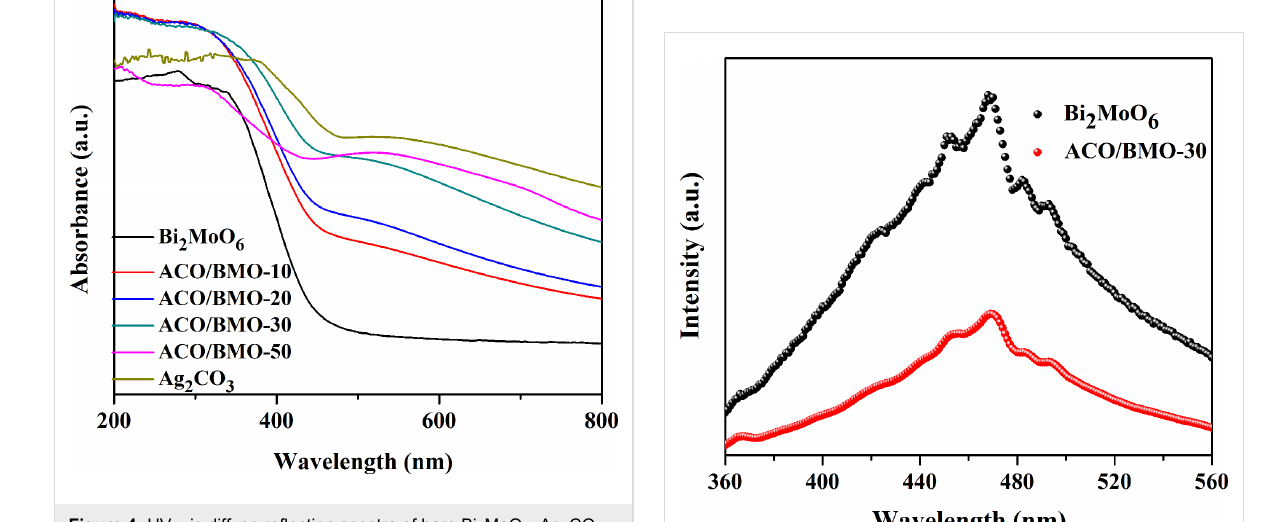
Figure 4: UV–vis diffuse reflection spectra of bare Bi 2 MoO 6 , Ag 2 CO 3 and Ag 2 CO 3 /Bi 2 MoO 6 heterostructures. The band gap energy ( E g ) can be estimated from the Tauc plot: ( α h ν ) = A ( h ν − E g ) n /2 . Where α , h , ν , and A are absorption coef- ficient, Planck’s constant, the frequency of light, and a constant,